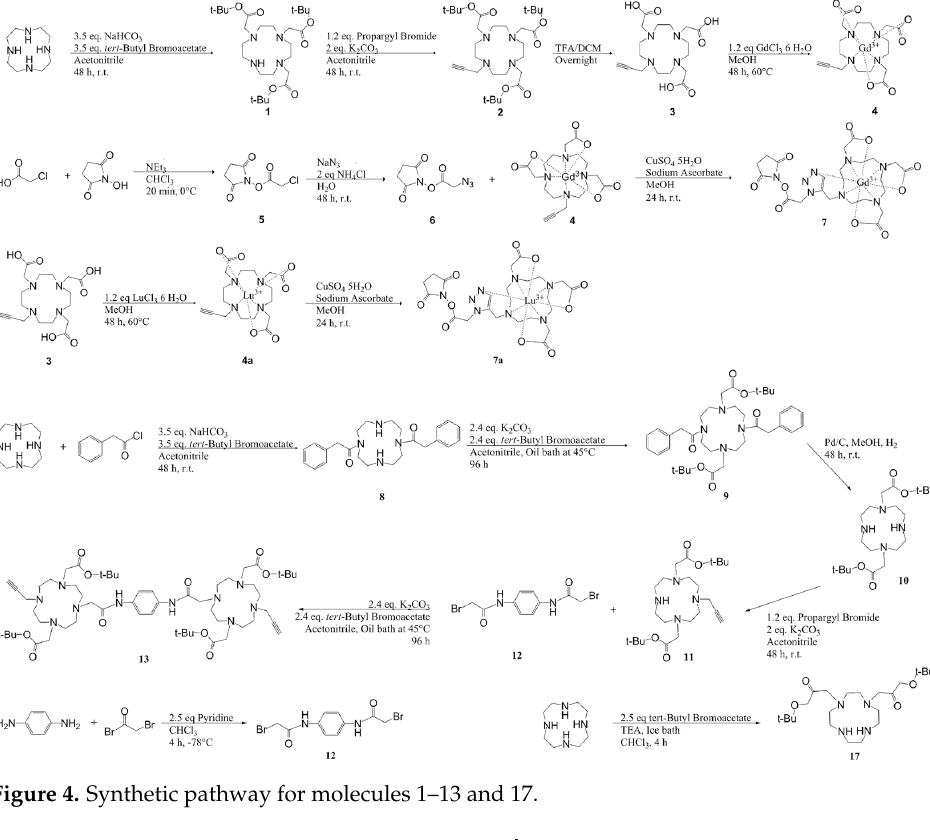
Figure 3. Closed tetrameric lanthanide complex.